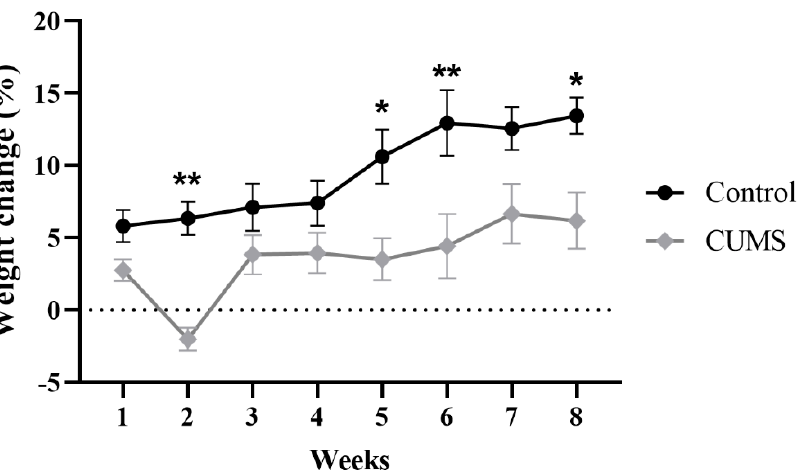
Figure 2. The effect of CUMS on the weekly percentage of weight change. Data are presented as mean ± standard error of the mean (SEM). Two-way repeated-measures ANOVA was used, followed by Šídák’s multiple-comparisons test. (*) indicates a significant difference between the CUMS and the control group at p > 0.05 and ** p < 0.01.